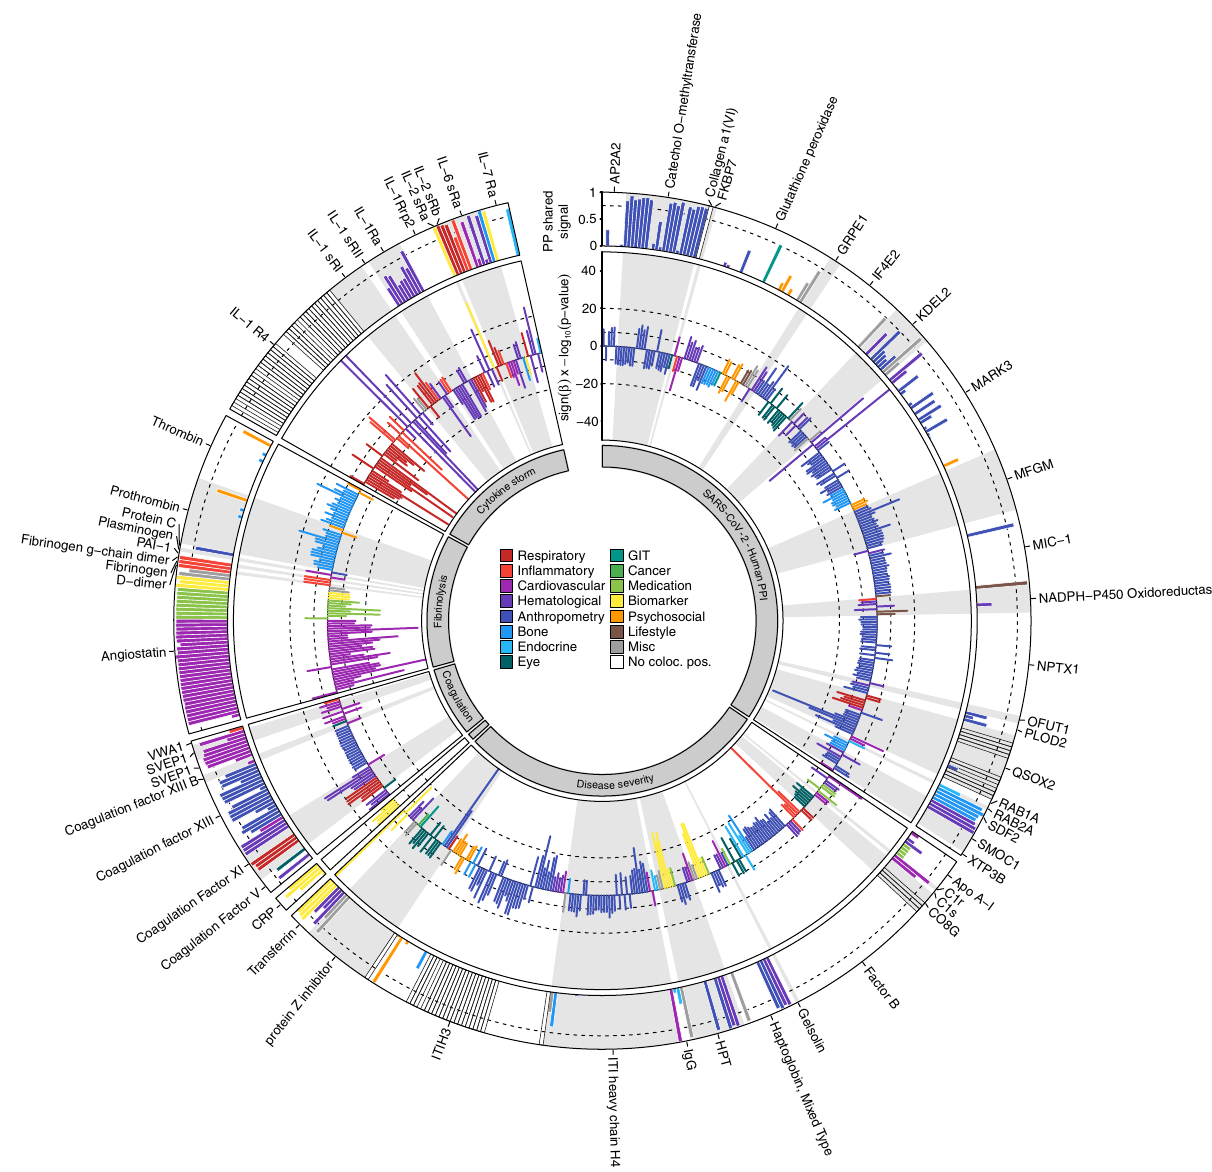
Fig. 6 Circos plot summarizing genome-wide signi fi cant associations between 74 cis -pQTLs and 239 traits 34 in the inner ring and results from statistical colocalization in the outer ring. The dashed line in the outer ring indicates a posterior probability of 75% of shared genetic signal between the protein and a phenotypic trait. Protein targets are classi fi ed on the basis of their reported relation to SARS-CoV-2 and COVID-19. Each slice contains any cis -pQTLs associated with the target protein annotated and effect estimates were aligned to the protein increasing allele, i.e., bars with a positive – log10 ( p -values) indicate positive associations with a trait from the database and vice versa. Clinical traits are grouped by higher-level categories and colored accordingly. GIT = gastrointestinal tract, Misc = Miscellaneous, No coloc. pos. = colocalization for secondary signals was not